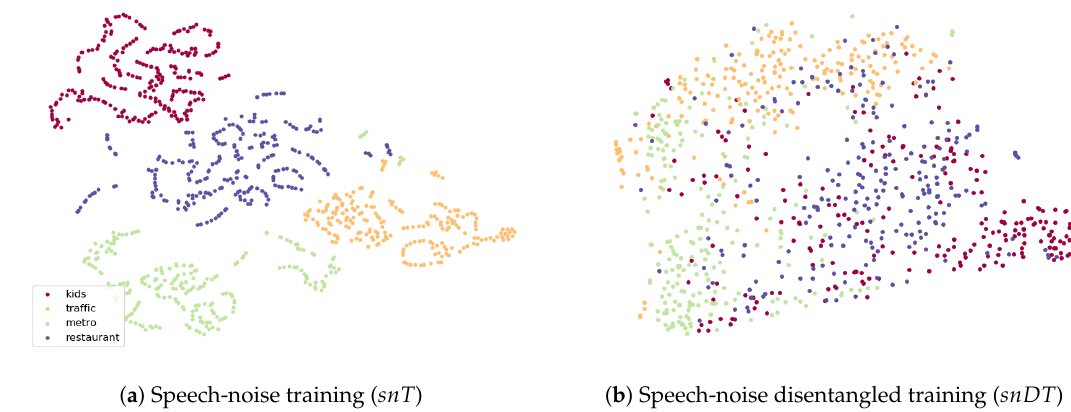
Figure 7. Visualization of speech latent feature ( z s ) using t-distributed stochastic neighbor embedding (t-SNE) in the matched noise condition.